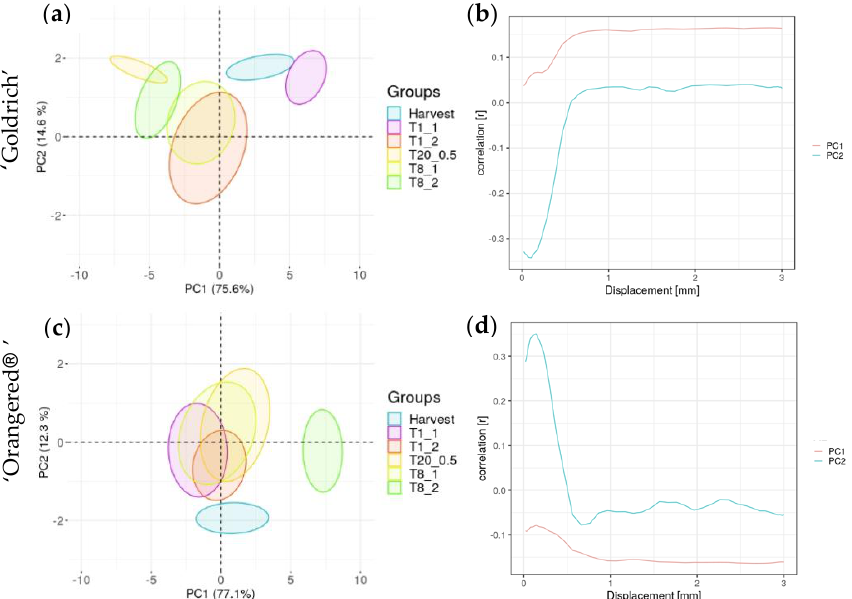
Figure 5. Principal component analysis (PCA) performed on force/displacement curves issued from puncture tests of the skin of ( a , b ) ‘Goldrich’ and ( c , d ) ‘Orangered ® ’ apricots at harvest and after 0.5 week at 20 °C (T20_0.5), 1 and 2 weeks at 1 °C and 8 °C (T8_1, T8_2, T1_1 and T1_2). ( a , c ): PCA scores, ( b , d ): PCs loadings.